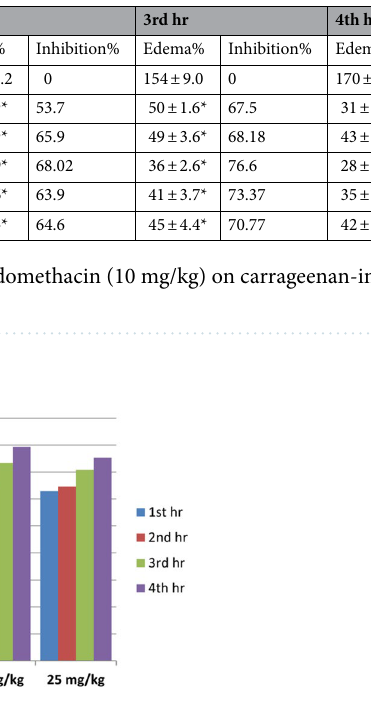
Figure 7. Effect of optimized extract and indomethacin on Carrageenan-induced rat paw edema